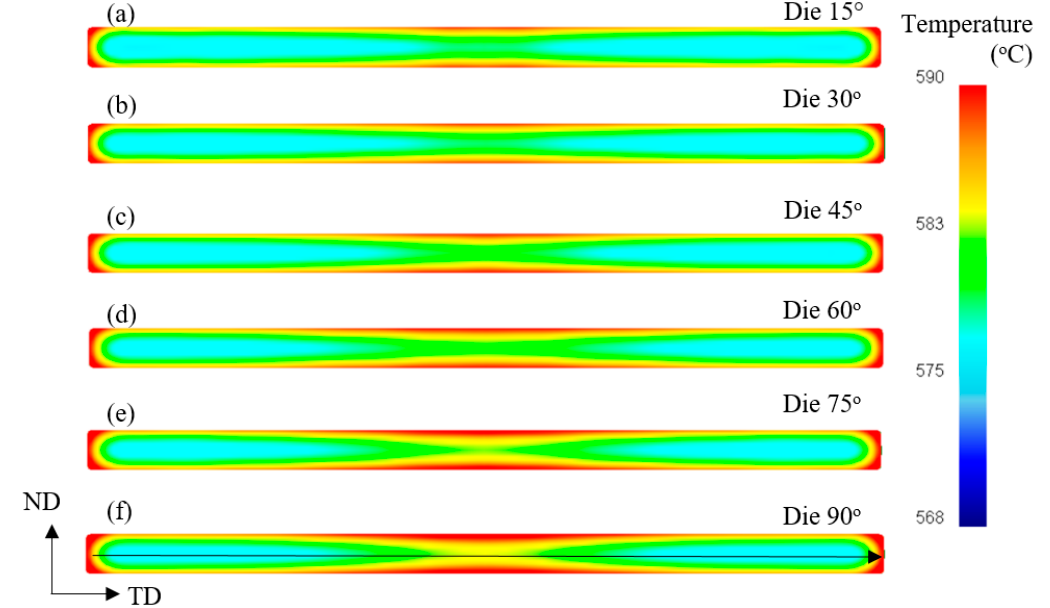
Figure 8. Cross-sectional view of the model-predicted extrudate’s exit temperature during porthole die extrusion for lower bridge angles of: ( a ) die 15°, ( b ) die 30°, ( c ) die 45°, ( d ) die 60°. ( e ) die 75° and ( f ) die 90°.